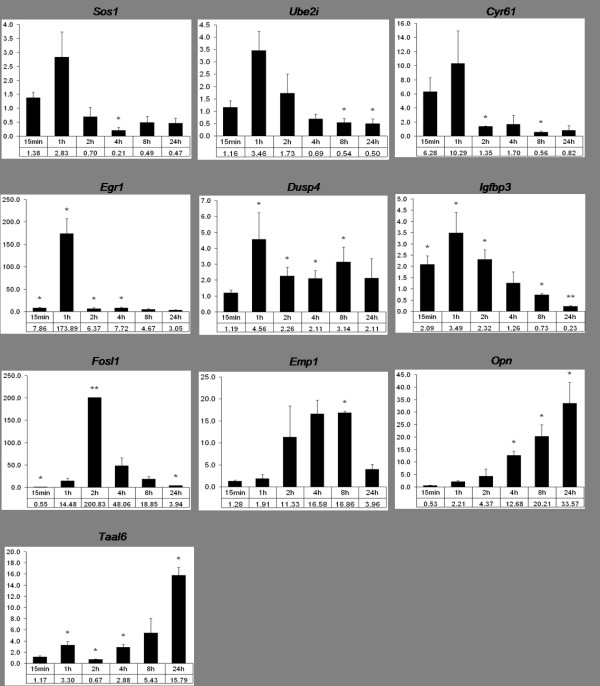
Validation of microarray results of ten candidate genes by quantitative realtime PCR. RNA was extracted at indicated time points after HERmrk stimulation with hEGF. Expression of candidate genes was compared to unstimulated cells. The fold change of transcript, referred to the unstimulated control, which is set as 1, is indicated on the y axis. Mouse β-actin served as reference gene. Significant regulation (p < 0.05) is marked by an asterisk; two asterisks indicate highly significant regulation (p < 0.001) (Student's t-test, paired, one-tailed).